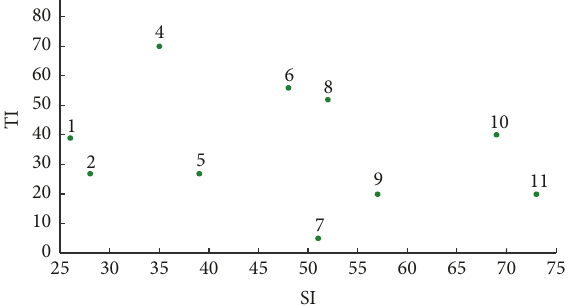
Table 2: Encoder configuration for H.265/HEVC